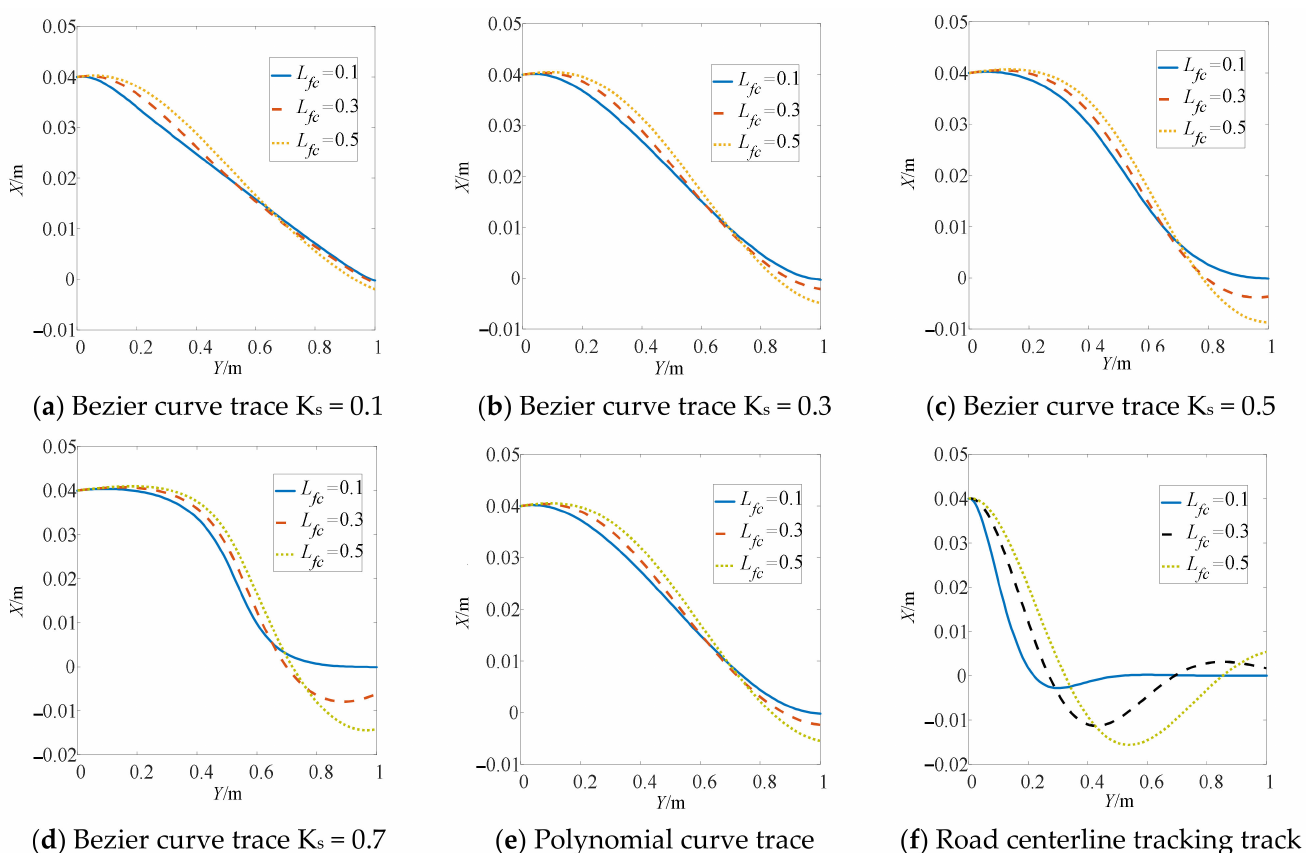
Figure 12. A comparison of tracking trajectories to different lookahead